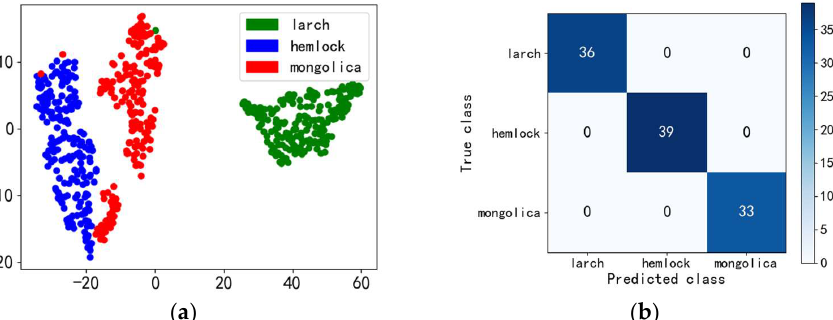
Figure 15. RF classification results of three coniferous woods: ( a ) Sample distribution of training set; ( b ) Confusion matrix of the test set.